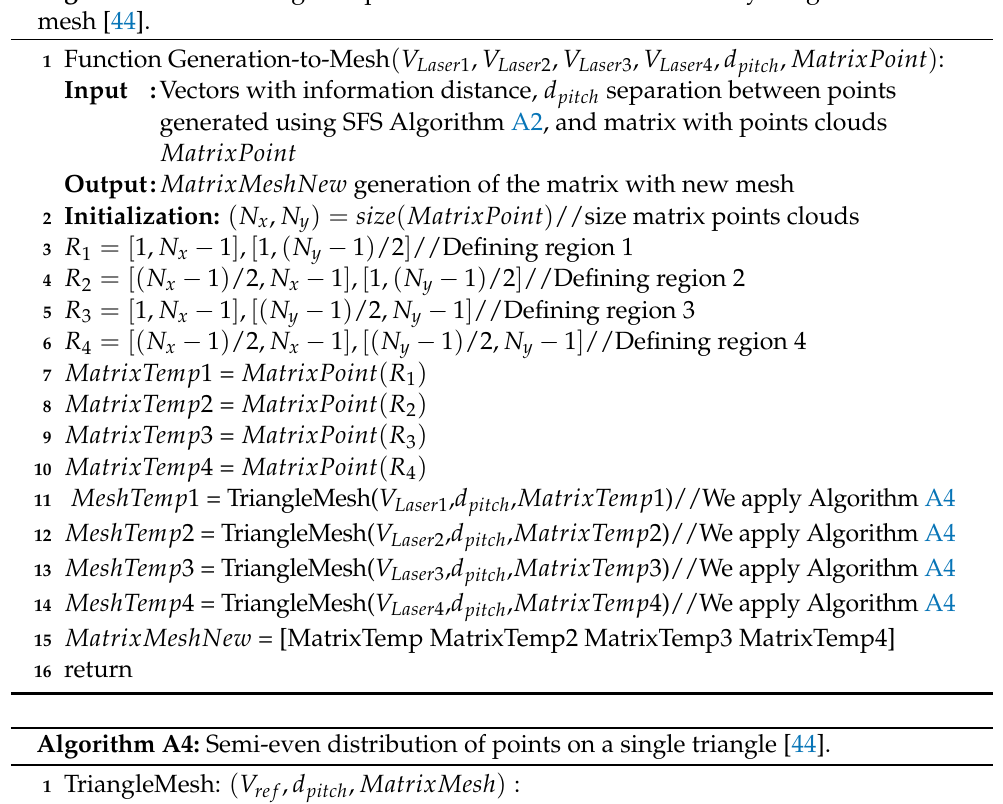
Algorithm A3: Finding the points of contact of the iTOF ray to generate mesh [44].